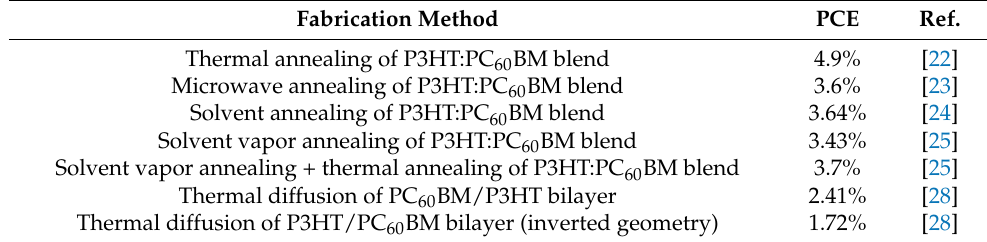
Table 1. Summary of fabrication method and performance of P3HT:PC 60 BM solar